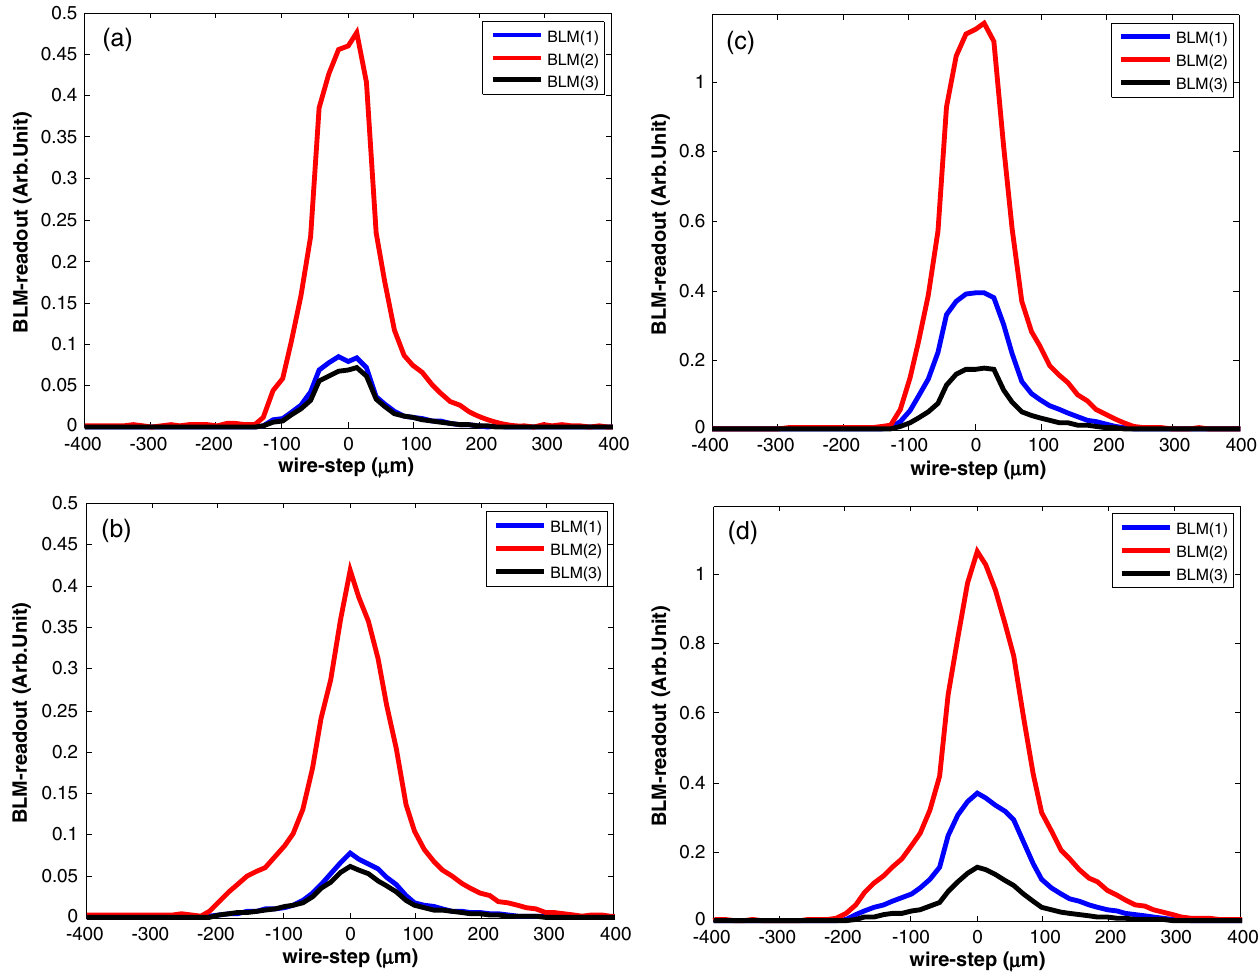
FIG. 15. Horizontal — (a,c) and vertical — (b,d)- wire-scanned profiles of the FERMI electron beam (1.5 GeV, 300 pC). In each figure, signals from the three BLMs placed at different distances from the WSC are plotted: BLM(1) at 2.48 m, BLM(2) at 5.52 m and BLM(1) at 8.40 m. Experimental data in (a,b) results from a scan with 5 μ m tungsten wire, while data (c,d) from a scan with a 13 μ m tungsten wire. The scan was performed at a wire-fork speed of 0 . 20 mm = s corresponding to a wire-step of 0.14 mm per rf shot at the machine repetition rate of 10 Hz. The measured beam size in the horizontal and vertical directions is σ ¼ 53 μ m and σ ¼ 80 μ m (rms), respectively, with a statistical error of about 2%.